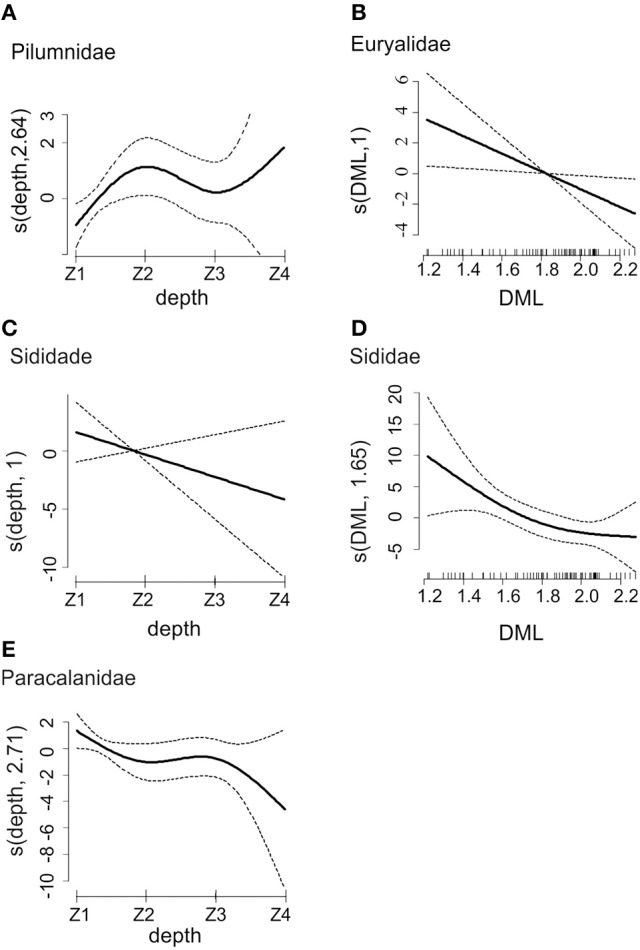
Smooth curves for partial effects obtained by the Generalized Additive Modeling (GAM) of the occurrence of the families Pilumnidae (A), Euryalidae (B), Sididae (C,D), and Paracalanidae (E) as prey of O. vulgaris paralarvae. Explanatory variables used were dorsal mantle length (DML) and depth (Z1, Z2, Z3, Z4). Dotted lines are 95% confidence bands. The vertical axis represents the effect on the response variable.